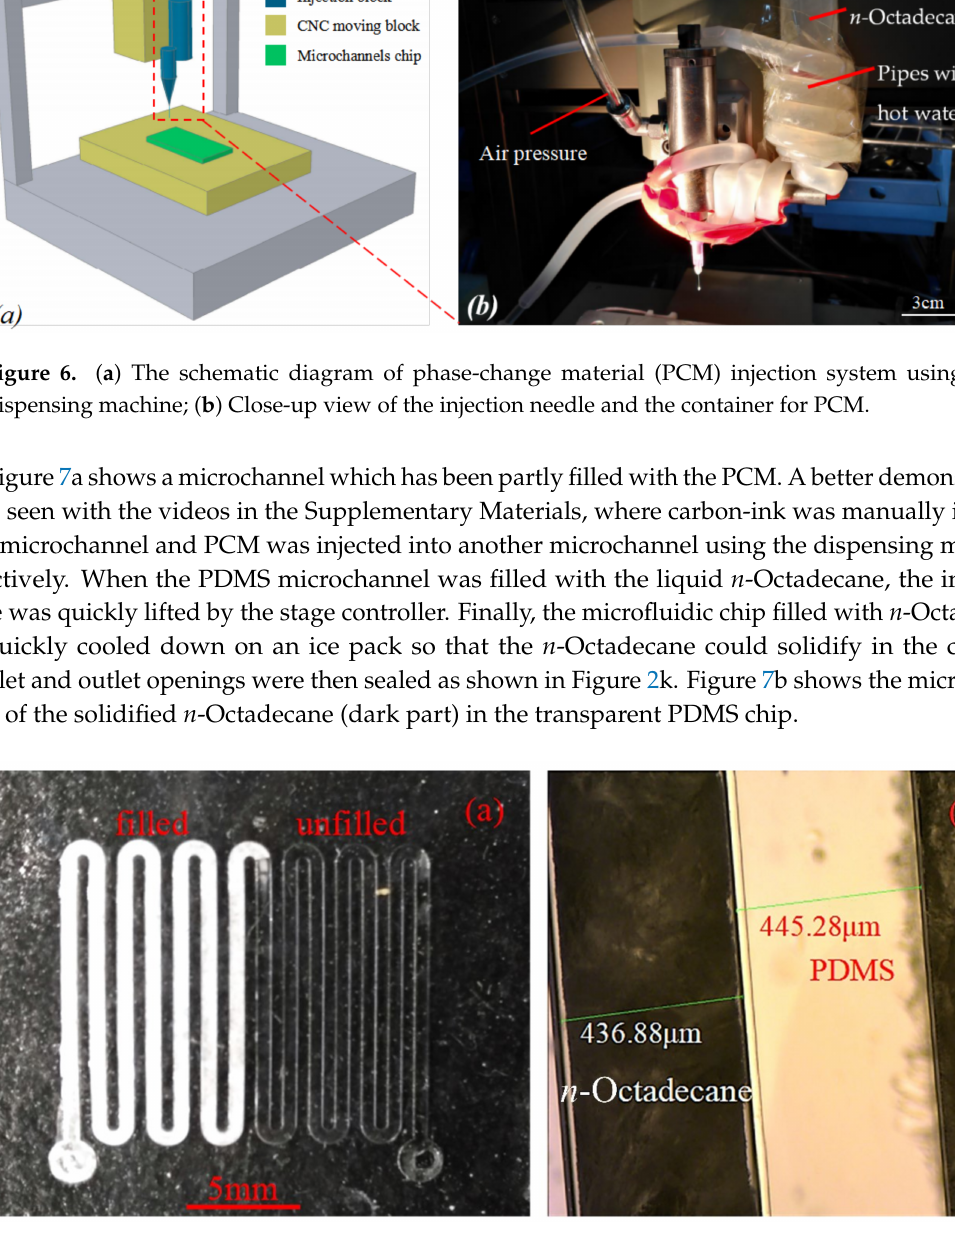
Figure 7. ( a ) The microchannel is partly filled with n -Octadecane which could solidify at room temperature; ( b ) the n -Octadecane turns to dark under microscopy due to the disorder of crystal